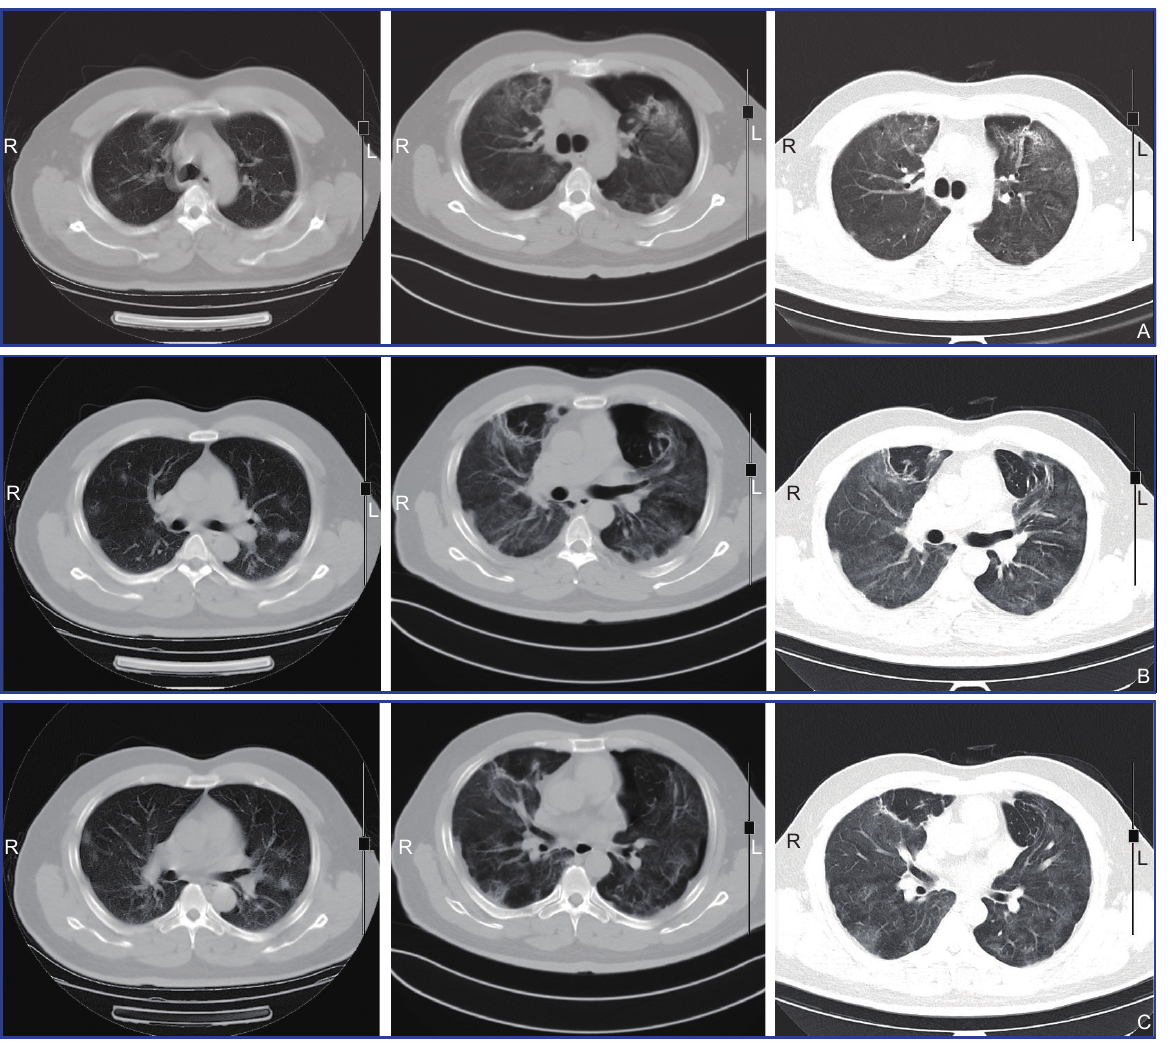
Figure 2 Chest CT findings. (A) On January 18, the bilateral lung field had normal brightness and increased lung texture, considering bilateral pneumonia; (B) On February 15, the texture of bilateral lungs became thicker, increased, and blurred, scattered in patchy, flocculent blurry shadows, with blurred edges, left pneumothorax, lung tissue compression by 30%, and bilateral lung infection; (C) On February 21, bilateral lung texture was enhanced, and both lungs became brighter. Patches of the lungs were scattered under the pleura and patchy indistinct shadows. The lesions improved, bilateral emphysema and bilateral alveoli, the lateral pneumothorax has improved